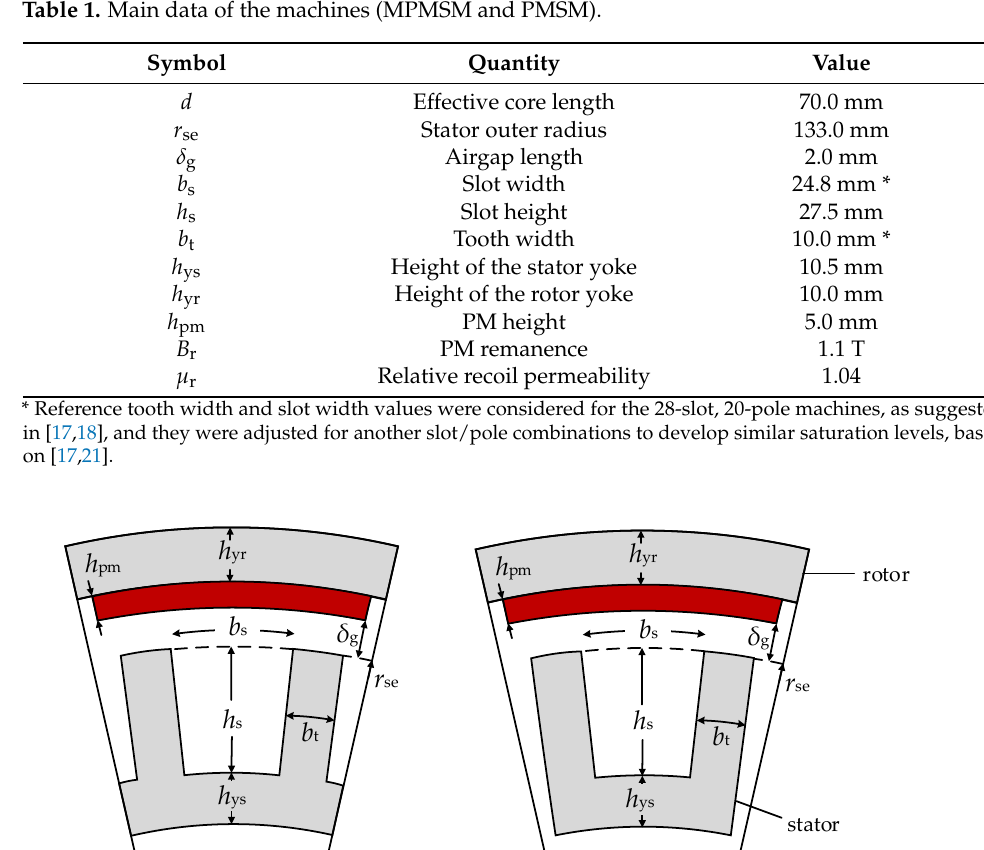
Table 1. Main data of the machines (MPMSM and PMSM).